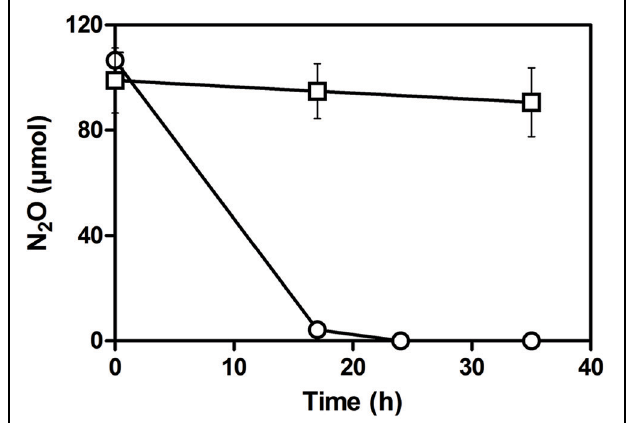
FIGURE 2 | N 2 O reduction by strain JAM1. Strain JAM1 was cultured in triplicate under anaerobic conditions with nitrate (40 mM) and N 2 O (circle). A control with no biomass was also conducted (square).